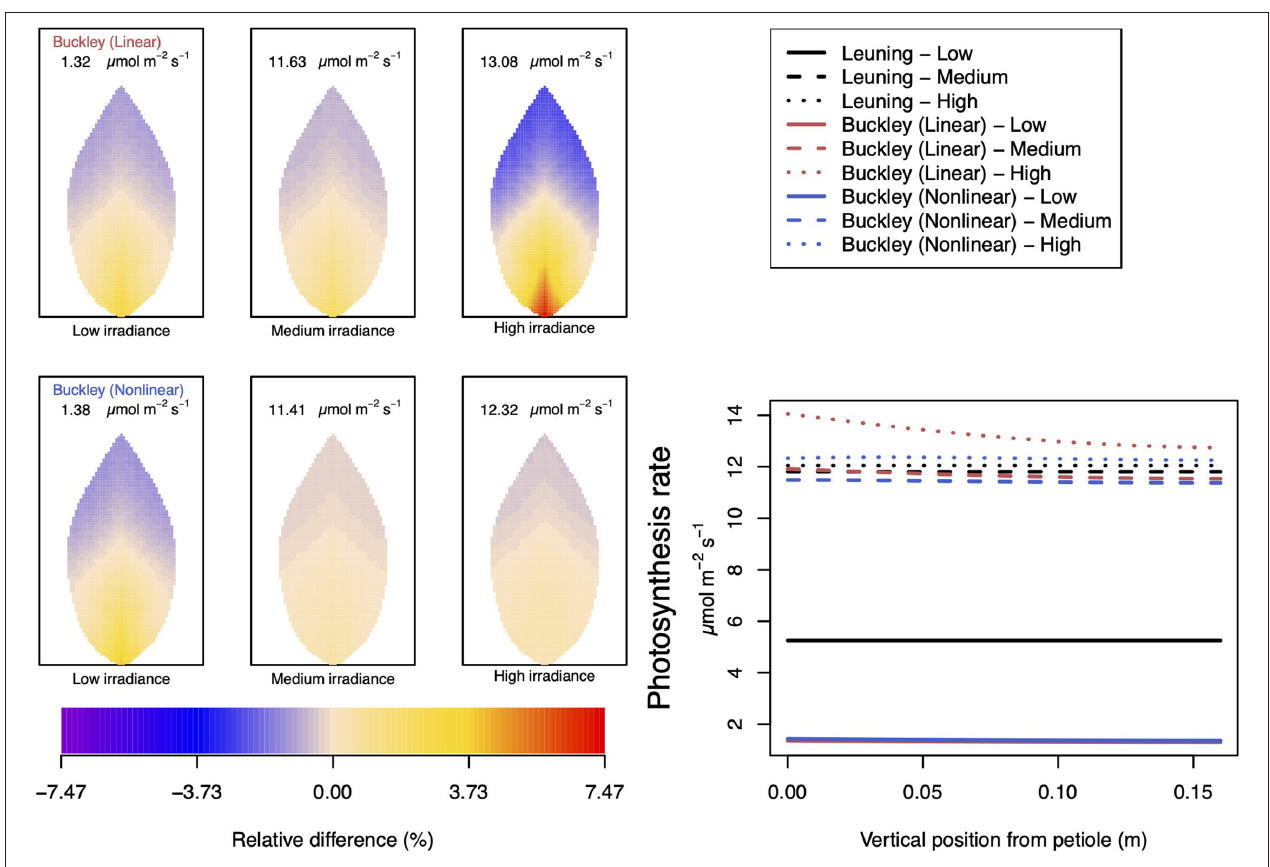
FIGURE 9 | A comparison of predictions of photosynthetic activity distributed over the leaf according to the three stomatal conductance models of Leuning (1995) (black lines in right hand figure), linear (Buckley et al., 2003) (top row of panels and red lines in the right hand figure), and nonlinear (Buckley et al., 2003) (bottom row of panels and blue lines in right hand figure). The 2D maps shown are deviations from leaf-area averages. The leaf-area average values of photosynthesis rates are given at the top of each panel. The three columns (left-to-right) and line styles (solid, dashed, dotted) show the respective dependencies on light intensity : low (200 µ mol m − 2 s − 1 ); medium (500 µ mol m − 2 s − 1 ); and high irradiance (1,000 µ mol m − 2 s − 1 ). For the Leuning (1995) model, the uniform predictions equal the